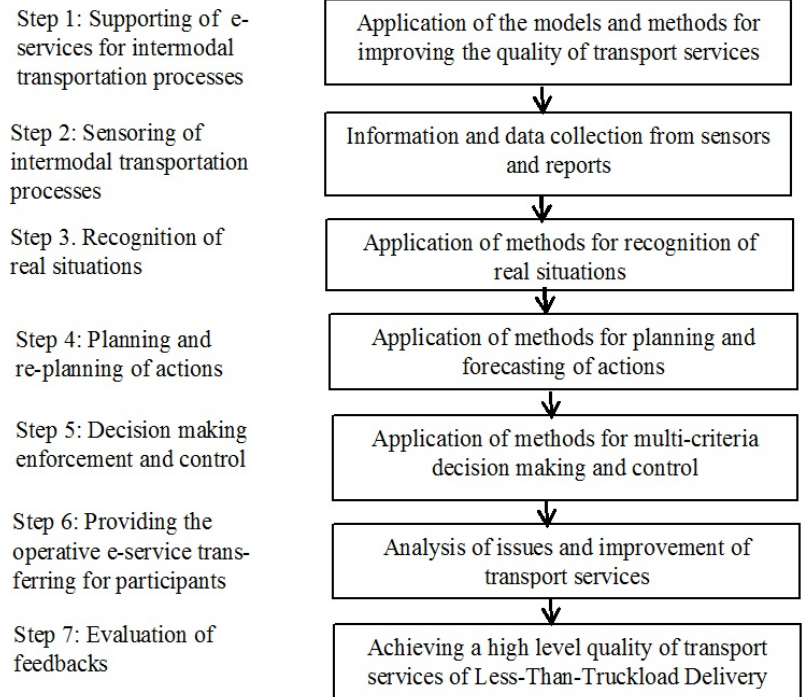
Figure 1. Main steps of realization of the infrastructure of the e-STMS.